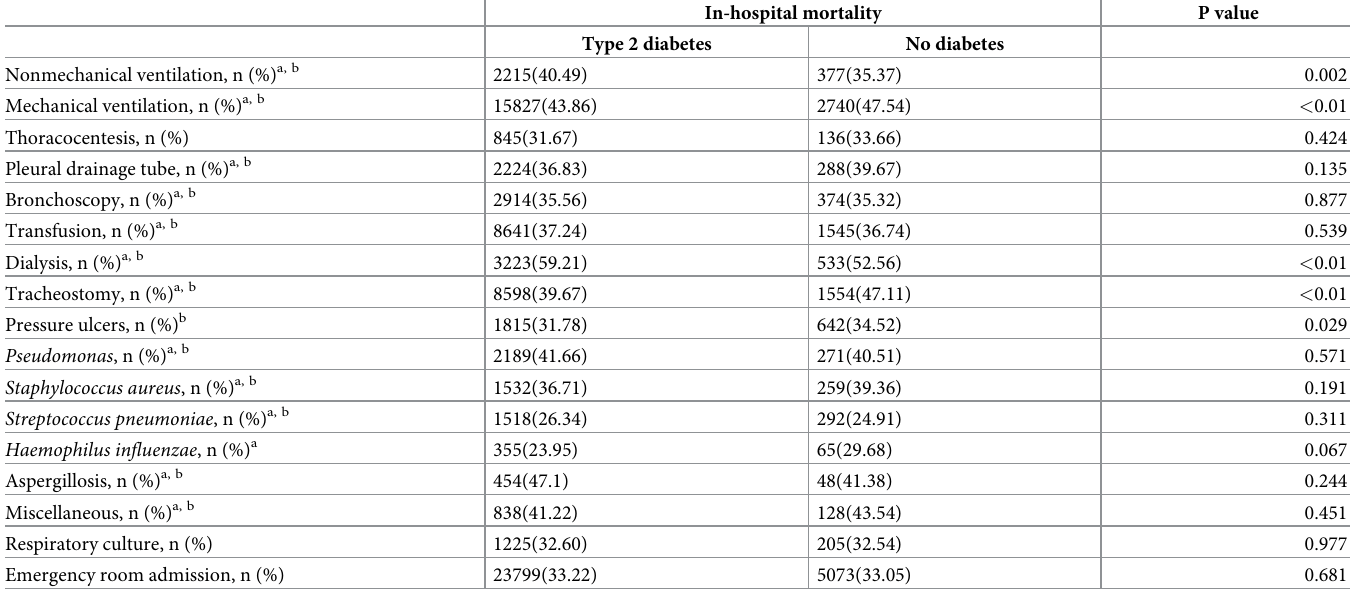
Table 4. Procedures, hospital outcomes and isolated pathogens of hospitalized patients with and without diabetes who suffered from postsurgical pneumonia according to hospitalization survival in Spain,